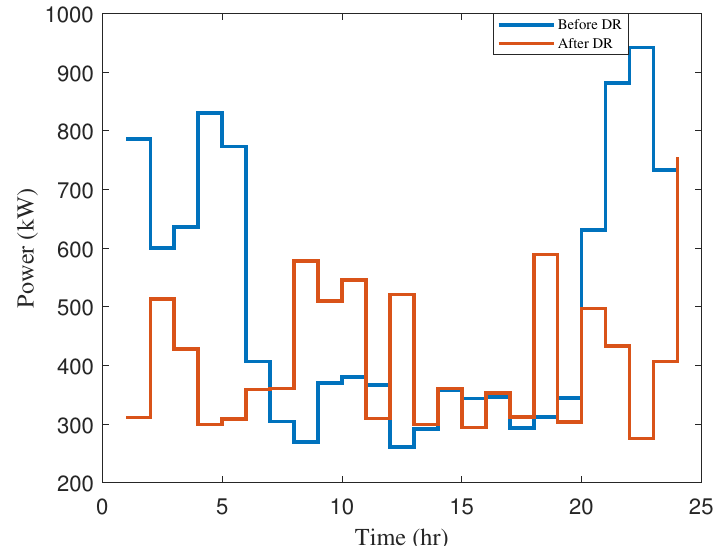
Figure 11. Optimal aggregate load reshapes considering peak load